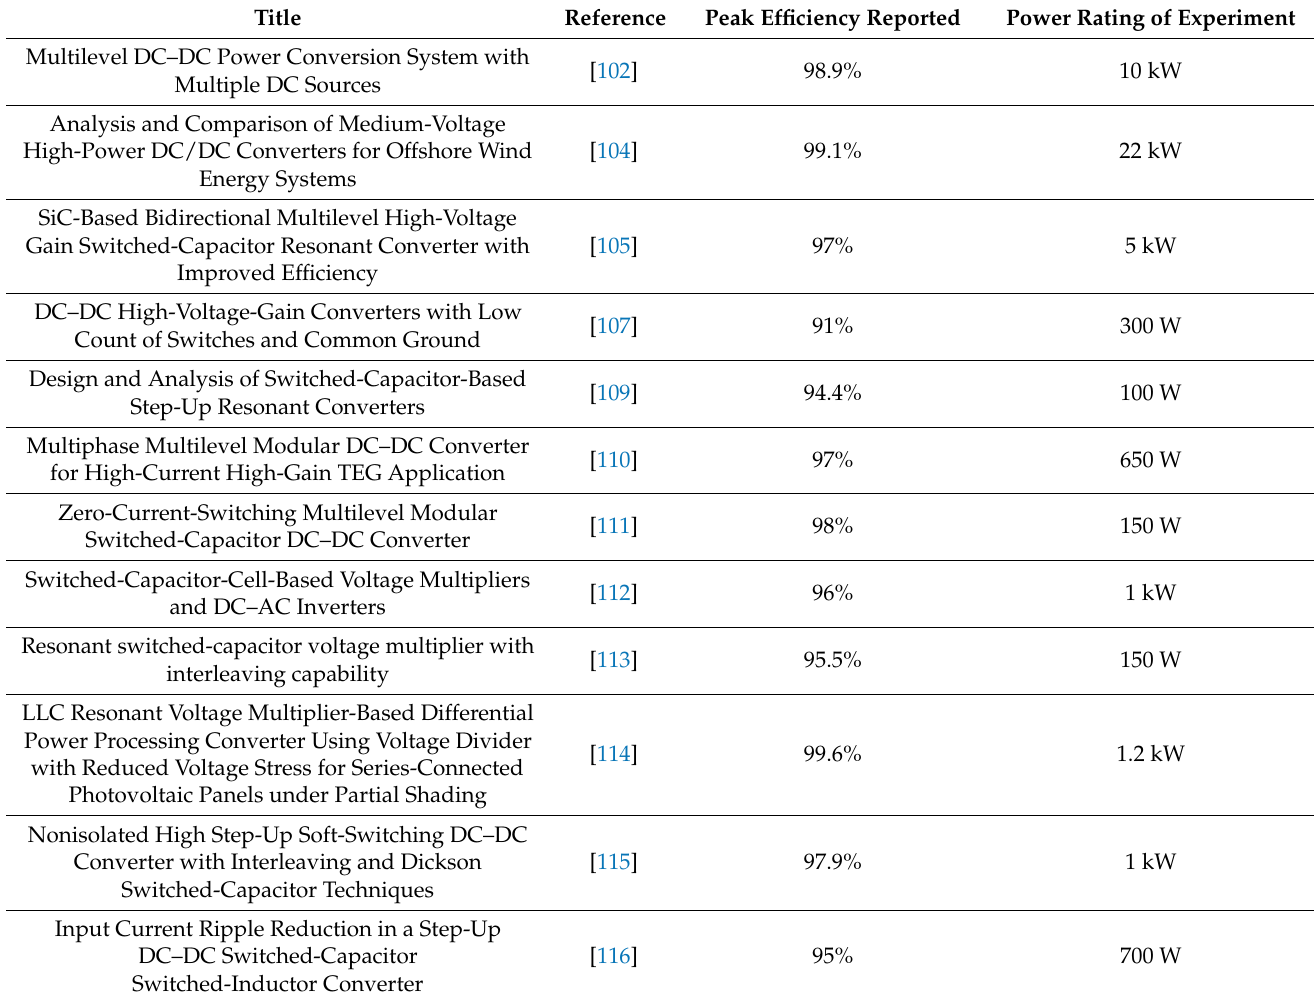
Table 2. References of switched-capacitor converters with high